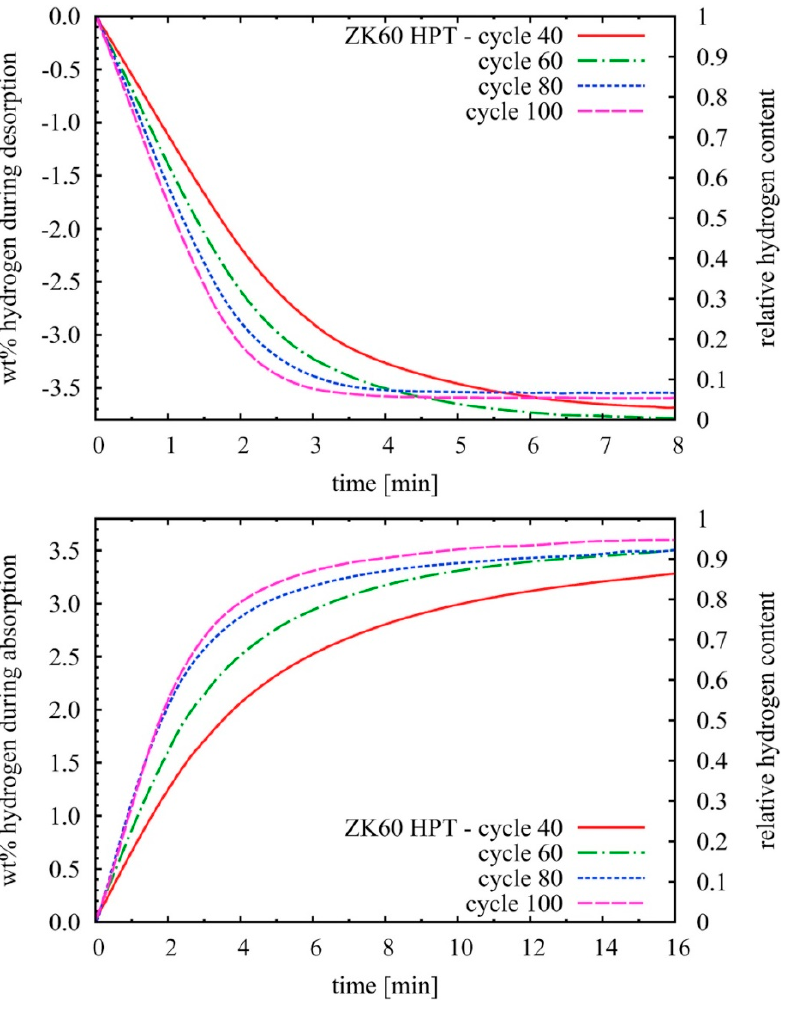
Figure 4. Dehydrogenation ( top ) and hydrogenation kinetic curves ( bottom ) obtained at 350 °C, 10 bar absorption pressure, 0.001 bar desorption pressure of the HPT-deformed ZK60 alloy [61].